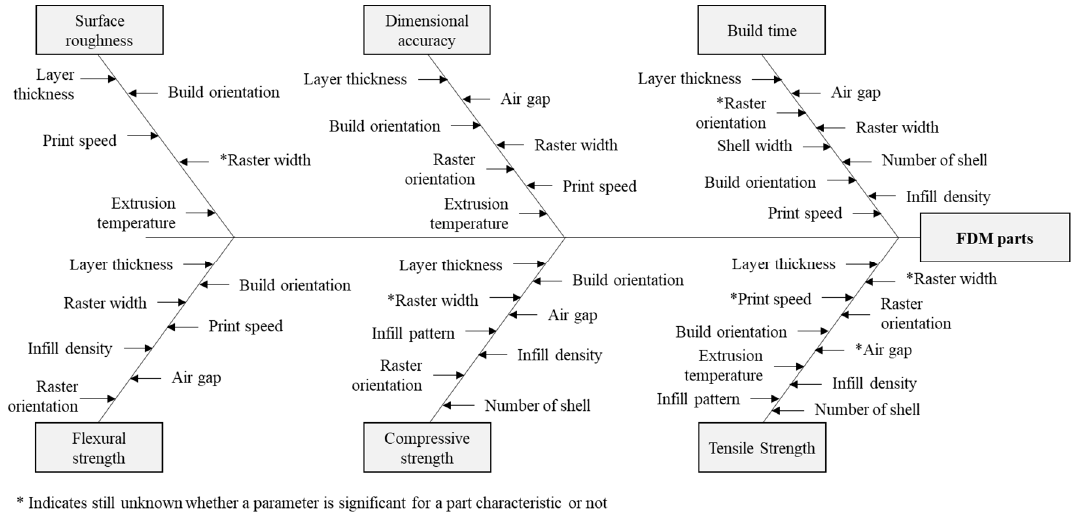
Figure 5. A fishbone diagram to illustrate the impacts of process parameters on part characteristics. 201